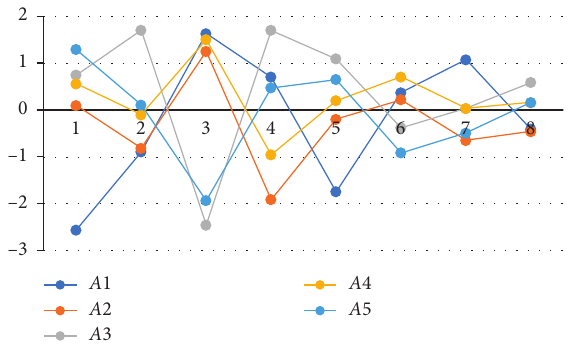
Figure 2: Sensitivity analysis